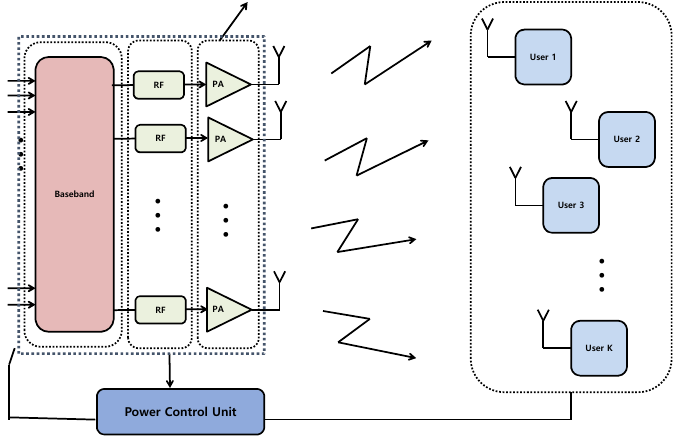
Figure 4. The high level conceptual figure of the energy-efficient future base station (BS).